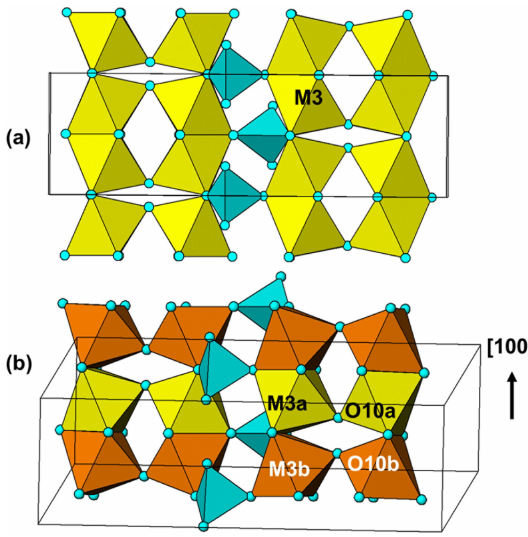
Figure 7. Comparison of the M 3 sites in (a) orthorhombic rockbridgeite-group minerals with (b) monoclinic manganrock- bridgeite.